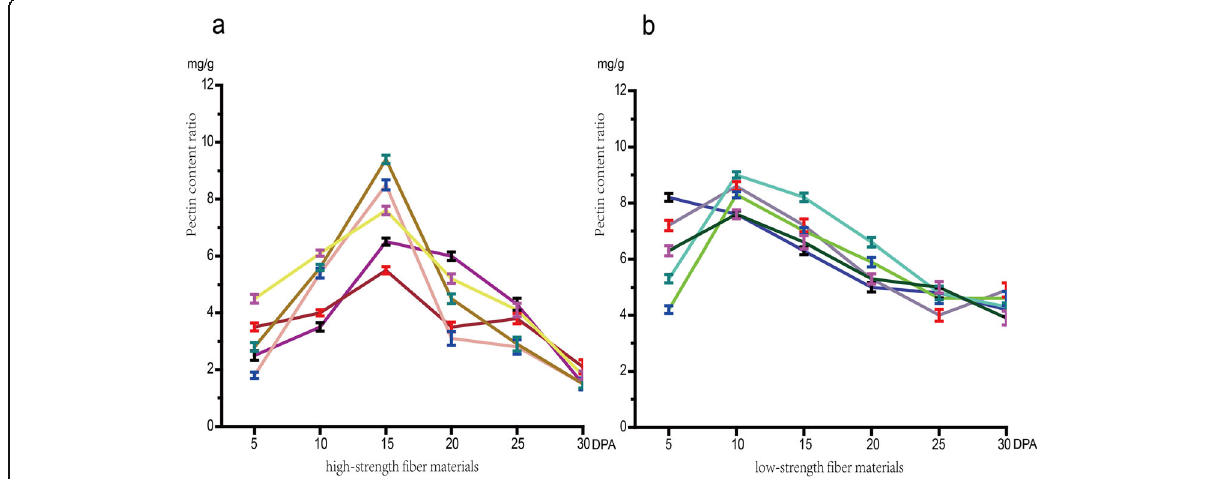
Fig. 6 The pectin content of different samples. a : 5 high-strength fiber materials; b : 5 low-strength fiber materials